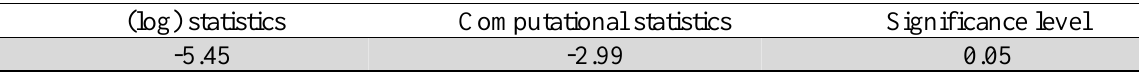
Unit root test for the residuals